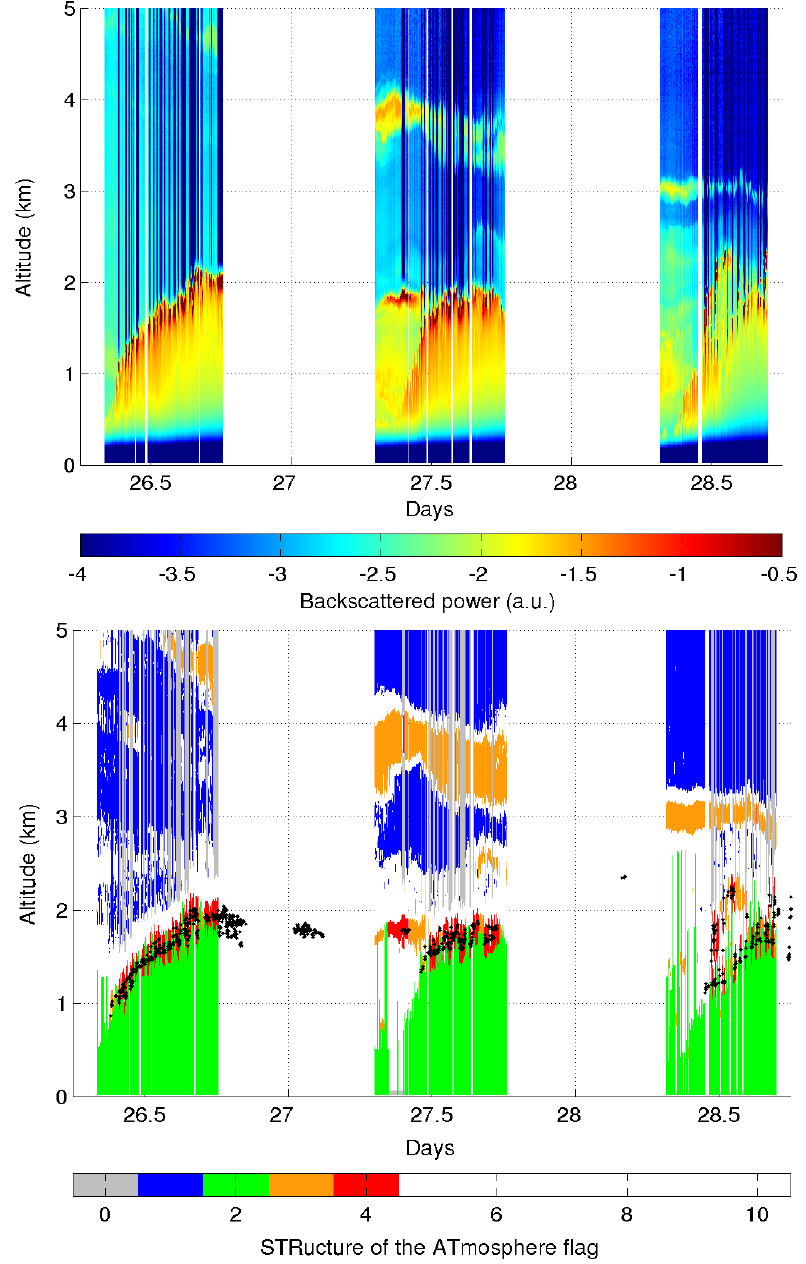
Fig. 8. Clouds and aerosols observed during the 26–28 May 2003 period. (a) Range-corrected backscattered lidar signal. Clouds at the top of the boundary layer appear in red (strongest backscattering). A persisting aerosol layer drops from 6 to 3km from 26 to 28 May. (b) Vertical structure mask of the atmosphere derived from 532-nm lidar backscattering signal. The boundary-layer height is shown in green, aerosol and cloud layers are labeled in orange and red, respectively. Black dots show cloud base height retrieved by ceilometer. Particle-free layers are shown in